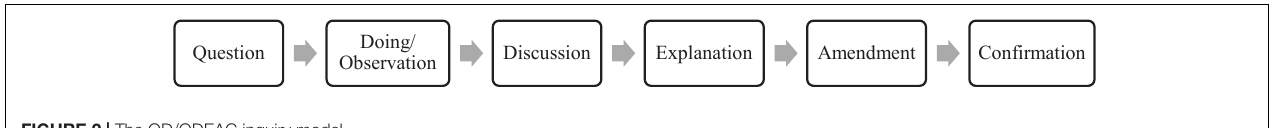
FIGURE 2 | The QD/ODEAC inquiry